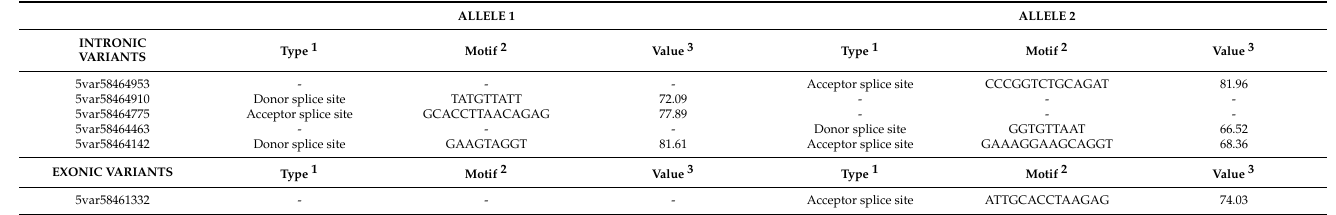
Table 2. Differential acceptor and donor splice sites identified by the HSF sequence analysis using the two sequences harboring the alternative